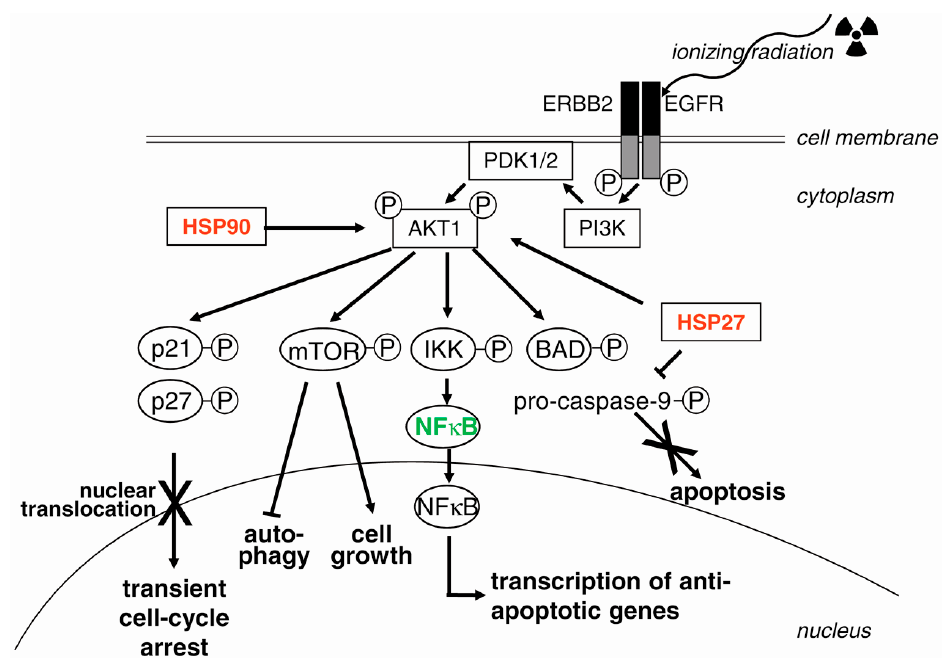
Figure 3. AKT1 as a proliferation and anti-apoptotic factor. Irradiation (symbolized by the sinuous arrow and the trefoil) of heterodimers of EGFR (epidermal growth factor; ERBB1) and of ERBB2 results in activation of PI3K. The subsequently activated PDK1 (pyruvate dehydrogenase kinase 1) and PDK2 phosphorylate and activate AKT1. AKT1 acts as an inhibitor of cell cycle arrest, since it phosphorylates p21 and p27; therefore, both proteins remain in the cytoplasm (indicated by the arrow with a cross) and cannot act as nuclear cell cycle inhibitors. The anti-apoptotic function of AKT1 is fulfilled by the activation of IKK (I-kappa-B kinase), which phosphorylates I κ B (I-kappa-B protein, not shown) falling off from the heterodimer with NF κ B (nuclear factor kappa-B, subunit 1), which then translocates to the nucleus, inducing transcription of anti-apoptotic genes. Furthermore, Akt1 suppresses apoptosis (indicated by the arrow with a cross) by phosphorylation and inactivation of the two pro-apoptotic proteins BAD (BCL2-associated agonist of cell death) and pro-caspase-9. HSP90 (heat shock protein 90) and HSP27 both stabilize AKT1 and promote degradation of I κ B, resulting in enhancement of NF κ B activity. HSP27 inhibits cleavage and thus activation of pro-caspase-9. Activation of MTOR (mechanistic target of rapamycin), on the one hand, stimulates cell growth and, on the other hand, inhibits autophagy. Arrows symbolize activation or translocation to the nucleus (described in the text); bar-headed lines symbolize inhibition. Targets for radiosensitization are in red, for radioprotection in green. See text for details.